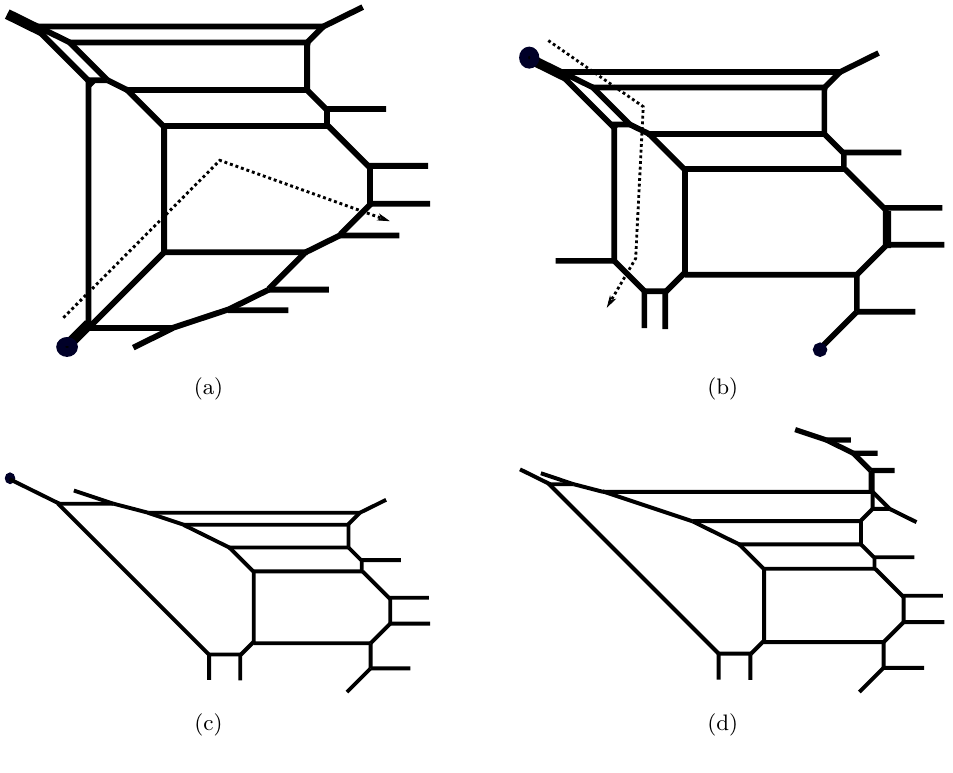
; N F = 6 ; (cid:20) = 5 . 2 2